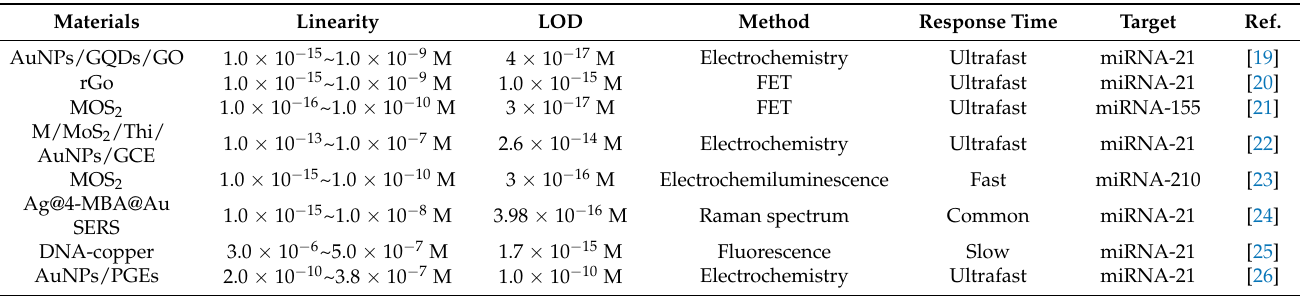
Table 1. Different materials/techniques for the detection of breast cancer target miRNA.